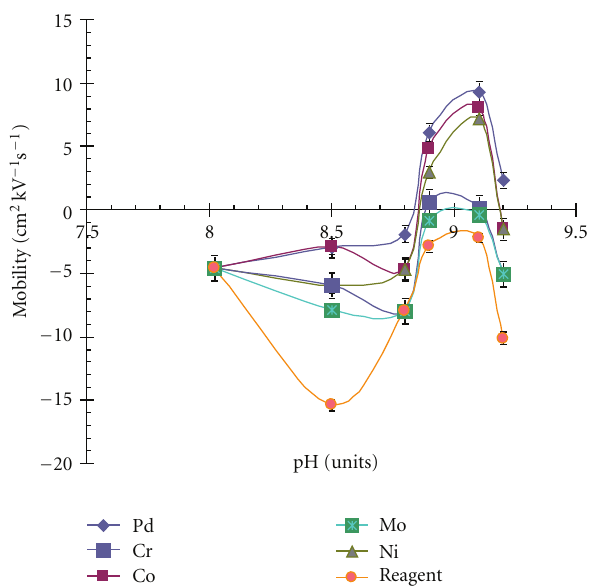
Figure 1: E ff ect of pH on the mobility of metal complexes with respect to neutral marker